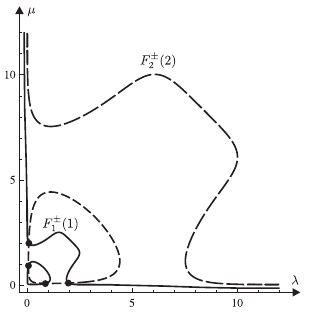
Figure 1. The case f = g = x 1 3 + x 32 , b − a = 2 . 5. Numerical calculations show that the branches F ± 1 (1) and F ± 2 (2) of the problem (1.1), (1.5) with α = 1 (full line) and α = 2 (dashed line) respectively do not coincide and have 4 points of